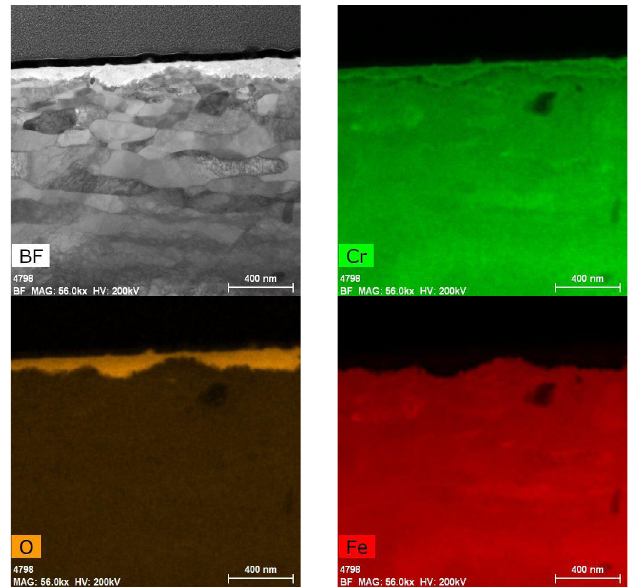
Fig. 5. Coupon of APMT exposed to PWR type water pure water+3.75 ppm hydrogen at 330 ° C for one year. A ∼ 150nm oxide layer rich in Cr is observed on its surface.